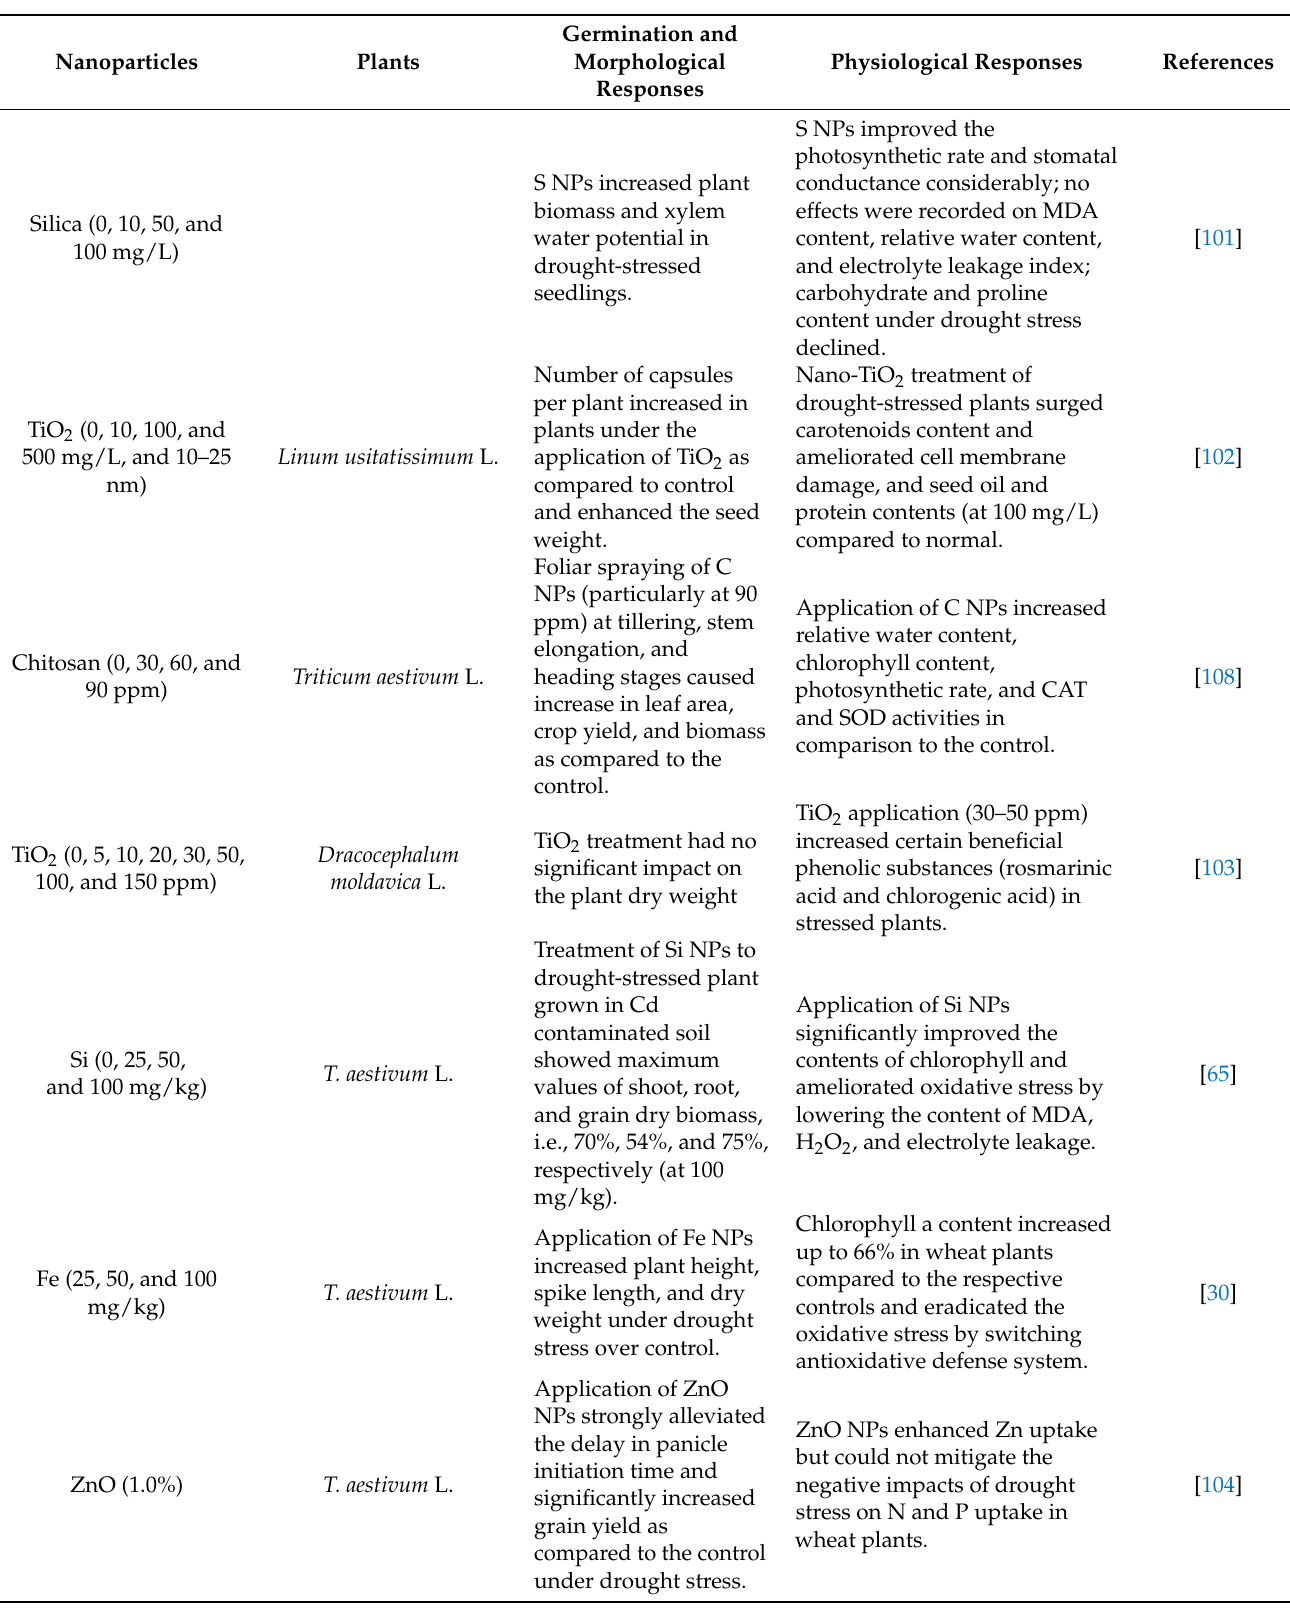
Table 3. Applications of nanoparticles in drought stress mitigation by altering the morphophysiological responses of plants.